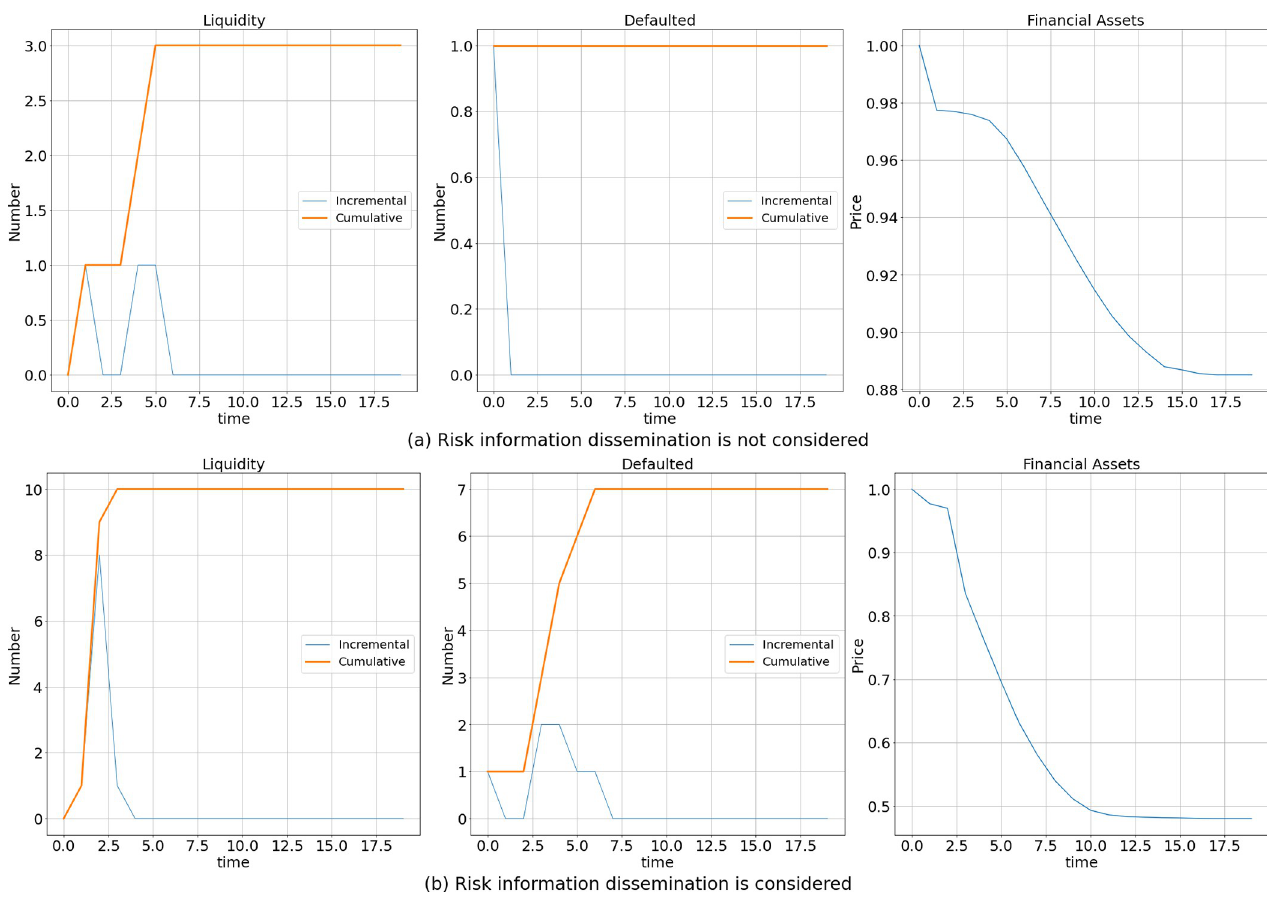
Fig 4. Effect of information dissemination after a bankruptcy